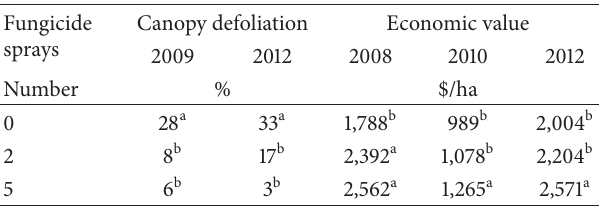
Table 9: Canopy defoliation and economic return as influenced by fungicide regime ∗ .